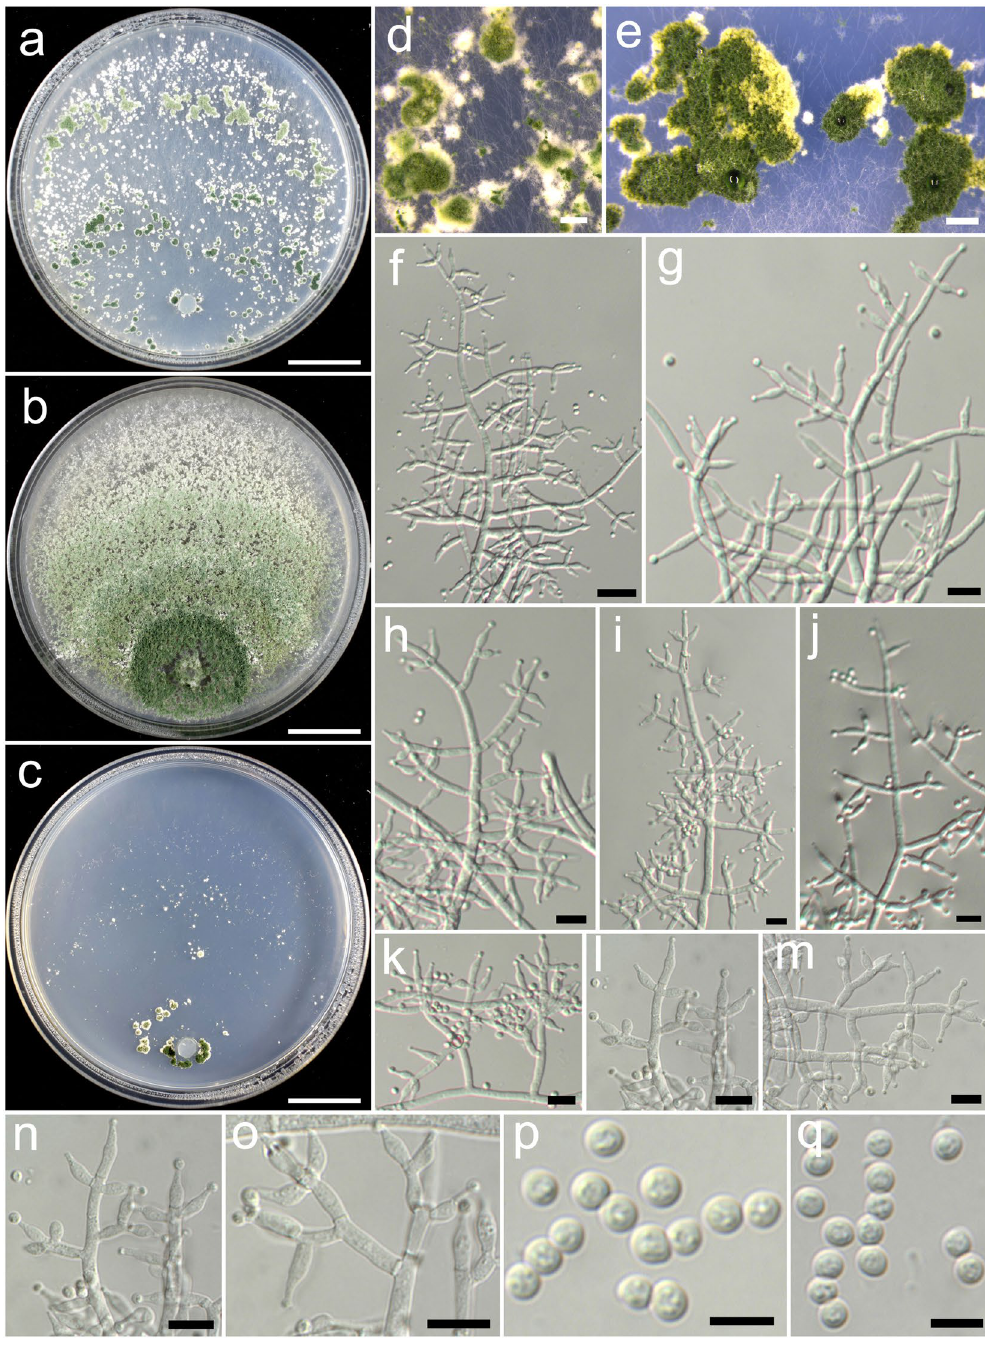
Figure 15. Trichoderma ingratum (HMAS 248822). ( a – c ) Cultures at 25 °C, 7 d (a. on CMD; b. on PDA; c. on SNA); ( d , e ) Conidial pustules (d. CMD, 7 d; e. SNA, 7 d); ( f – o ) Conidiophores and phialides (PDA, 4 d); ( p – q ) Conidia (PDA, 4 d). Bars: a–c = 20 mm. d–e = 500 μ m. f = 20 μ m. g–o = 10 μ m. p–q = 5 μ